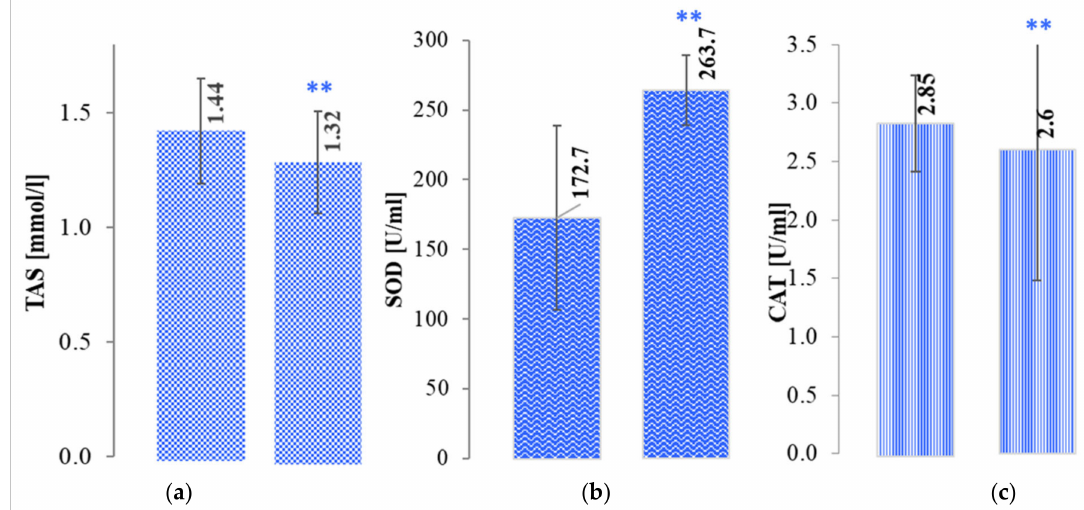
Figure 12. The activity of ( a ) TAS, ( b ) SOD and ( c ) CAT in the control group and the post-chemoradiotherapy group (**).